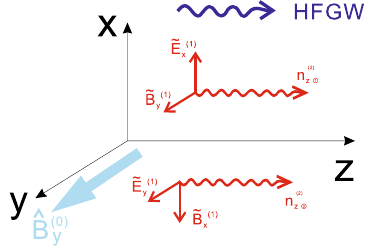
Fig. 3 When HFGW, Eq. (1), propagate in a transverse stable mag- ( 0 ) ( 2 ) ( 1 ) ˜ B ( 1 ) netic field ˜ B , Eq. (24), is generated by ˜ E y , the PPF n x and y , z 1 (cid:9) containingcontributionsfromboth ⊕ -typeand l -typepolarizations,and ( 2 ) ( 1 ) ˜ B ( 1 ) the PPF n , Eq. (25), is produced by ˜ E y and x containing only z 2 (cid:9) contribution from ⊗ -type